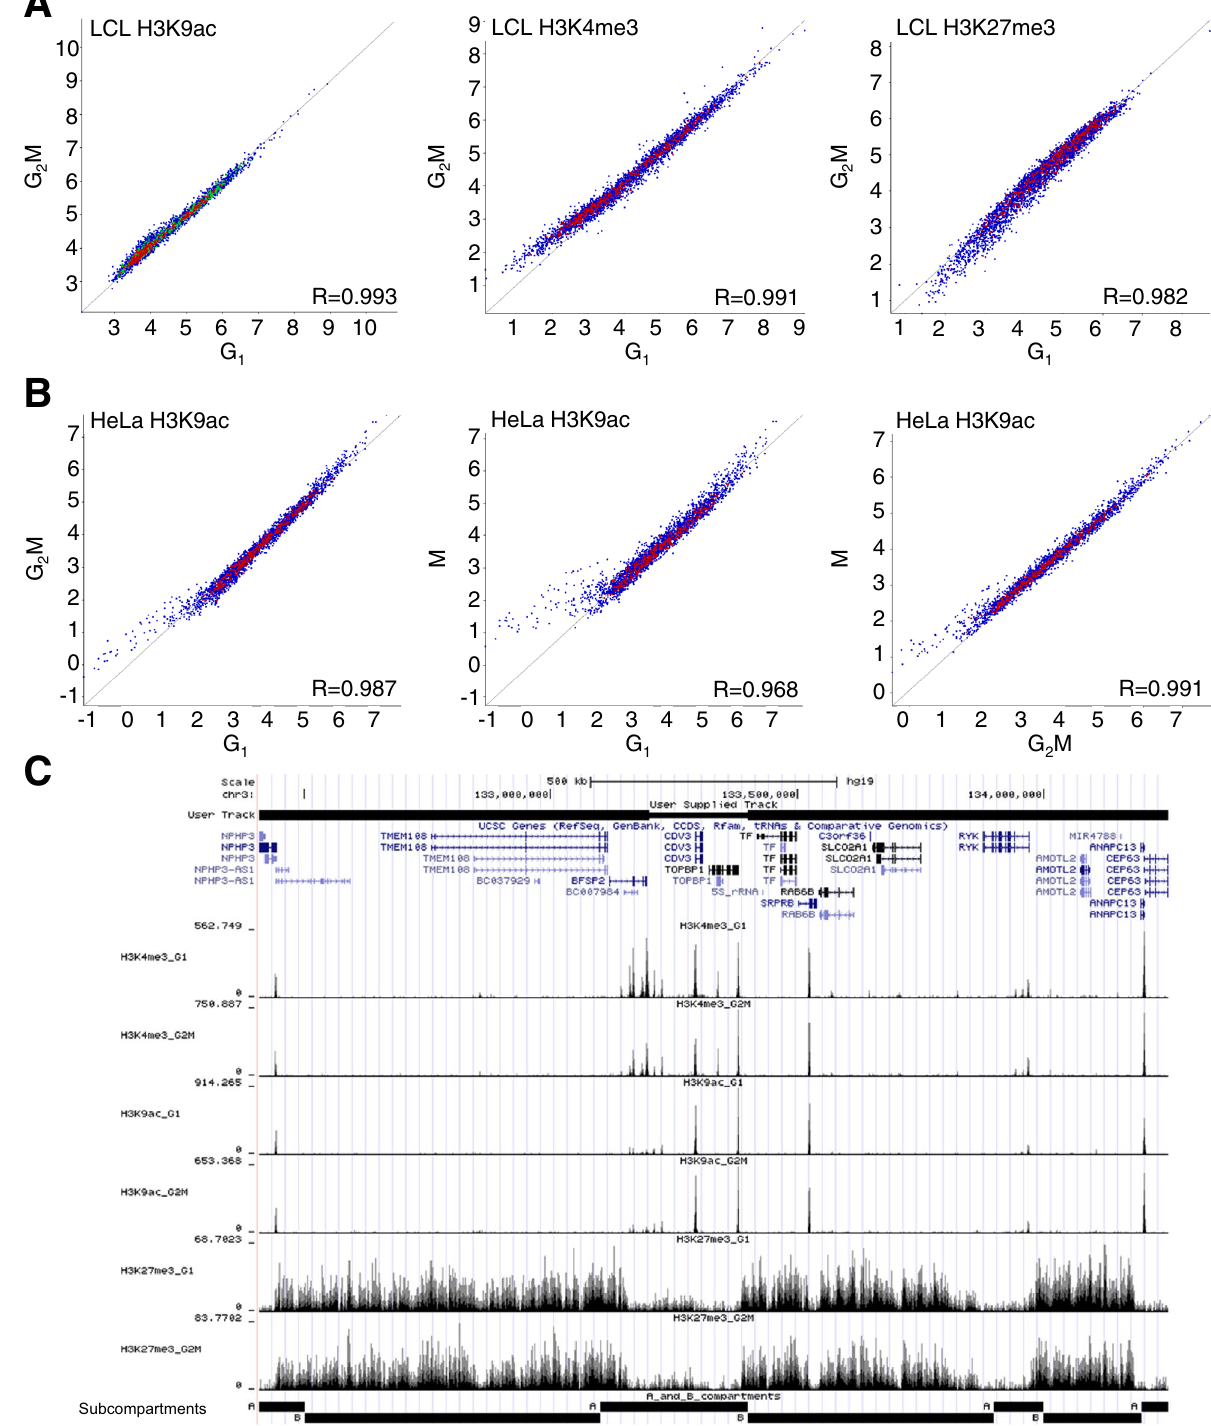
Figure 4. Histone modification levels are conserved within topological domains throughout the cell cycle. ( A ) Comparison of H3K9ac, H3K4me3 and H3K27me3 in G 1 vs. G 2 M in FACs–sorted LCL and ( B ) H3K9ac in HeLa in G 1 vs. G 2 M, G 1 vs. M and G 2 M vs M (elutriated/MSO). Topological domain coordinates from Rao et al. 16 (LCL) and Thiecke et al. 41 (HeLa) were used to define probes. Values represent log 2 read count normalised to total read count, corrected for probe size. Pearson R values are given for each correlation. ( C ) A genome browser screenshot of cell-cycle specific ChIP-seq data on chromosome 3. All tracks are from LCL. Topological A and B domains defined in the GM12878 LCL line 16 are